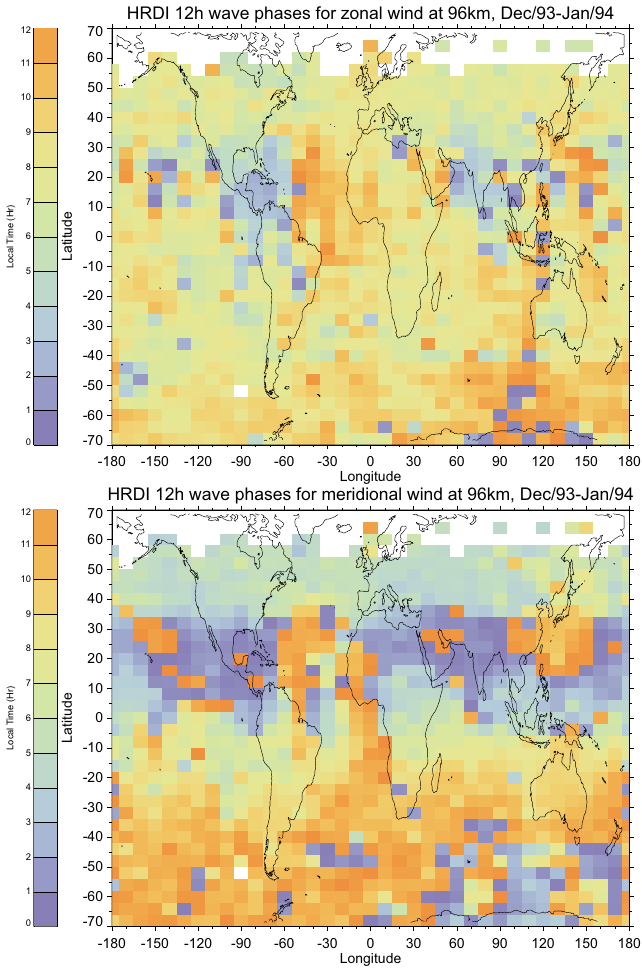
Fig. 10. Contoured plots of 12-h tidal phases for December 1993–January 1994 from